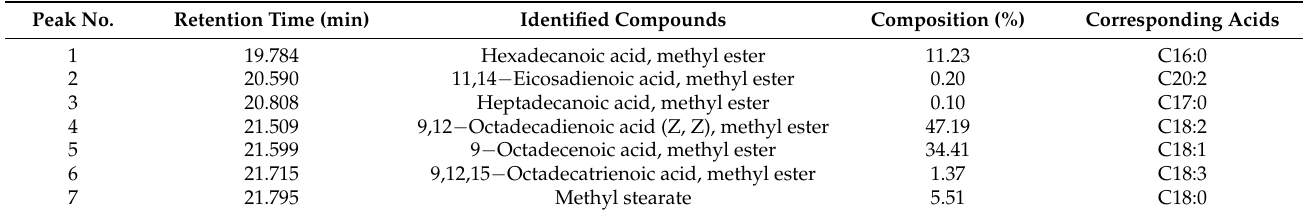
Table 1. Chemical composition of soybean biodiesel.